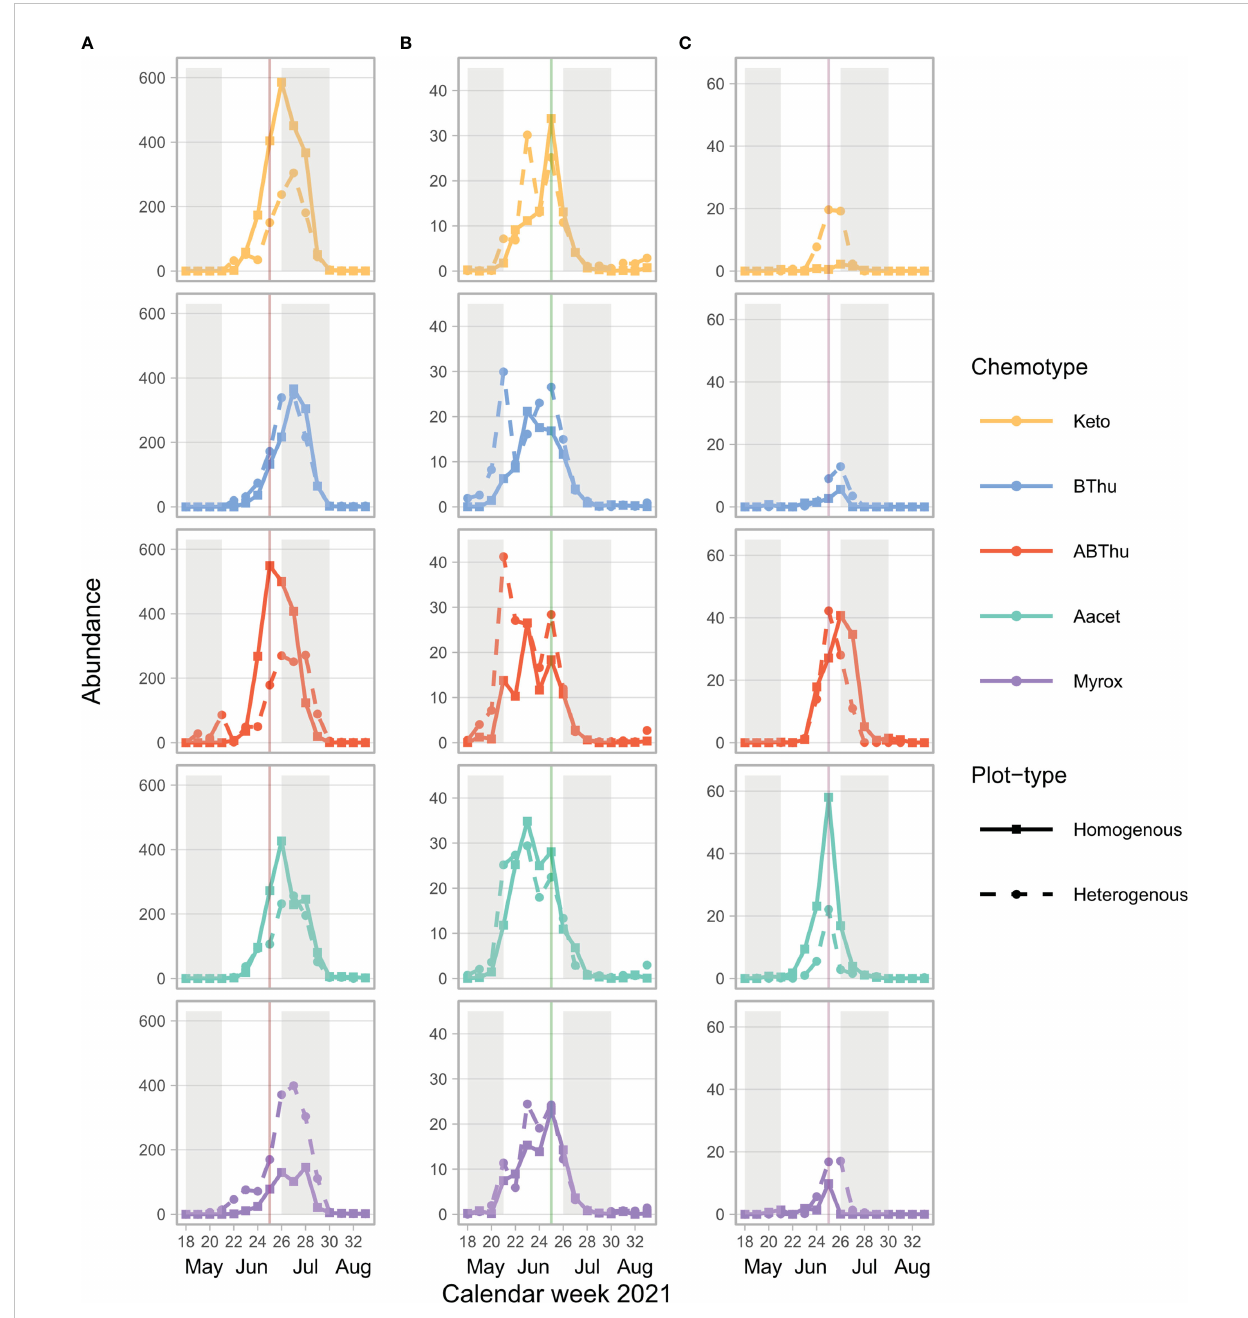
FIGURE 1 Mean total count of winged and unwinged aphids of (A) Uroleucon tanaceti , (B) Macrosiphoniella tanacetaria and (C) Metopeurom fuscoviride per calendar week on plants of Tanacetum vulgare grown in plots of fi ve individuals of the same (homogenous) or different (heterogenous) chemotypes (Keto, artemisia ketone chemotype; BThu, b -thujone chemotype; ABThu, a -/ b -thujone chemotype; Aacet, artemisyl acetate/artemisia ketone/artemisia alcohol chemotype; Myrox, ( Z )-myroxide/santolina triene/artemisyl acetate chemotype) across the season. Vertical lines indicate the calendar week in which the morphological and leaf terpenoid characterisation of the plants took place; n = 25-30 per chemotype x plot-type